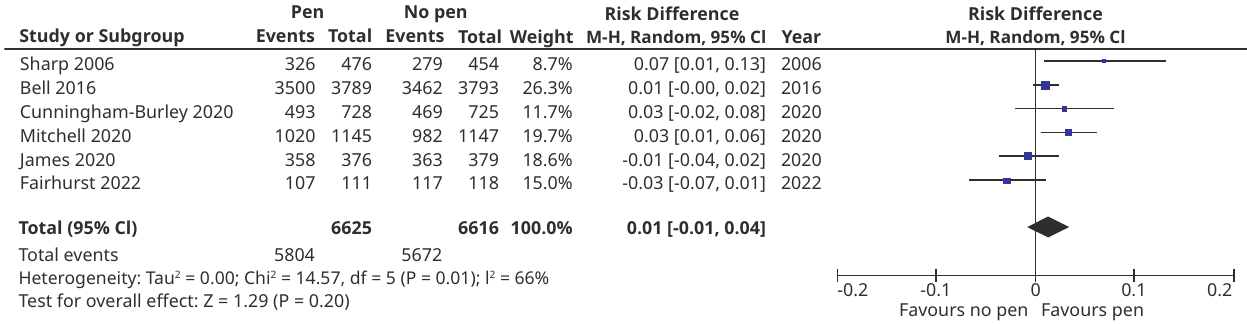
Figure 3. Meta-analysis of inclusion of a pen on questionnaire return